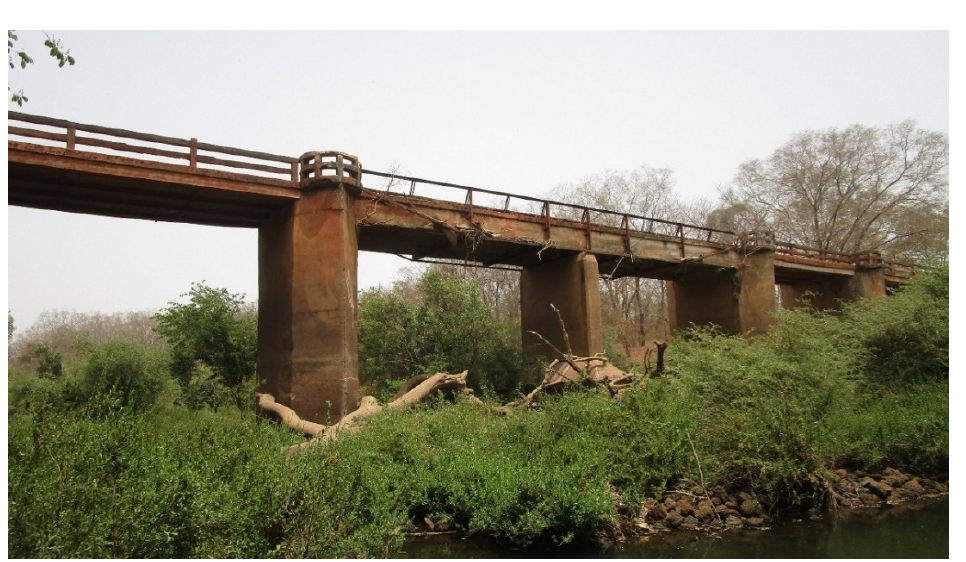
Figure 15. Bridge of the Koundara-Youkounkoun road, northern Guinea, on the Koulountou River. Built in the 1950s, it was flooded by the streamflow in August 2018, depositing whole trees (bottom) and wood debris (on the bridge deck).